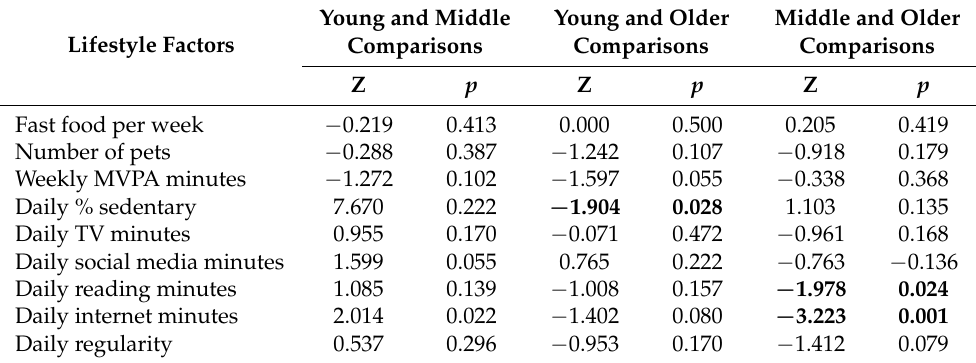
Young and Middle Young and Older Comparisons Comparisons